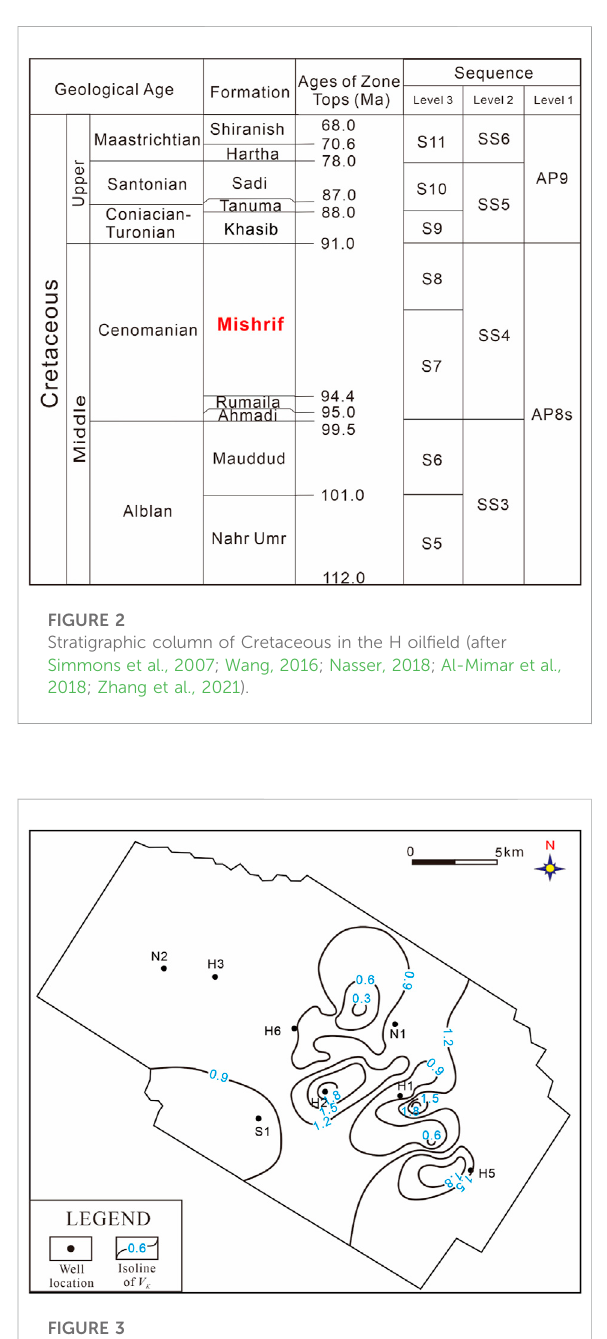
Planar distributions of the intermediate permeability variation coef fi cients of